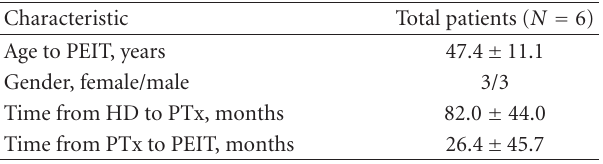
Table 1: Demographic and clinical data. Mean ±